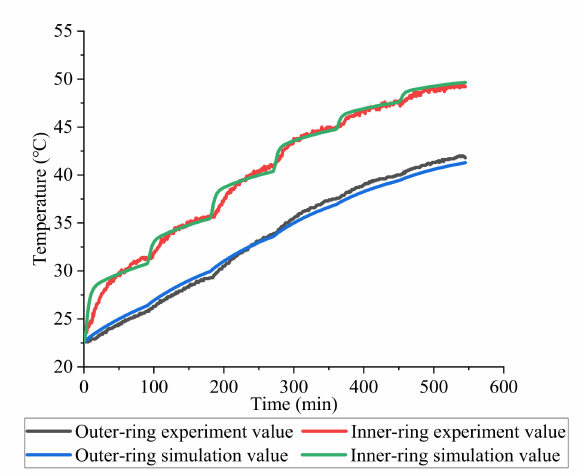
Figure 7. Comparison curve of the corrected temperature rise simulation value and the experimental value.